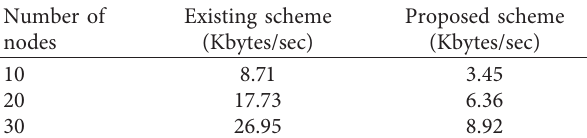
2: Communication cost.